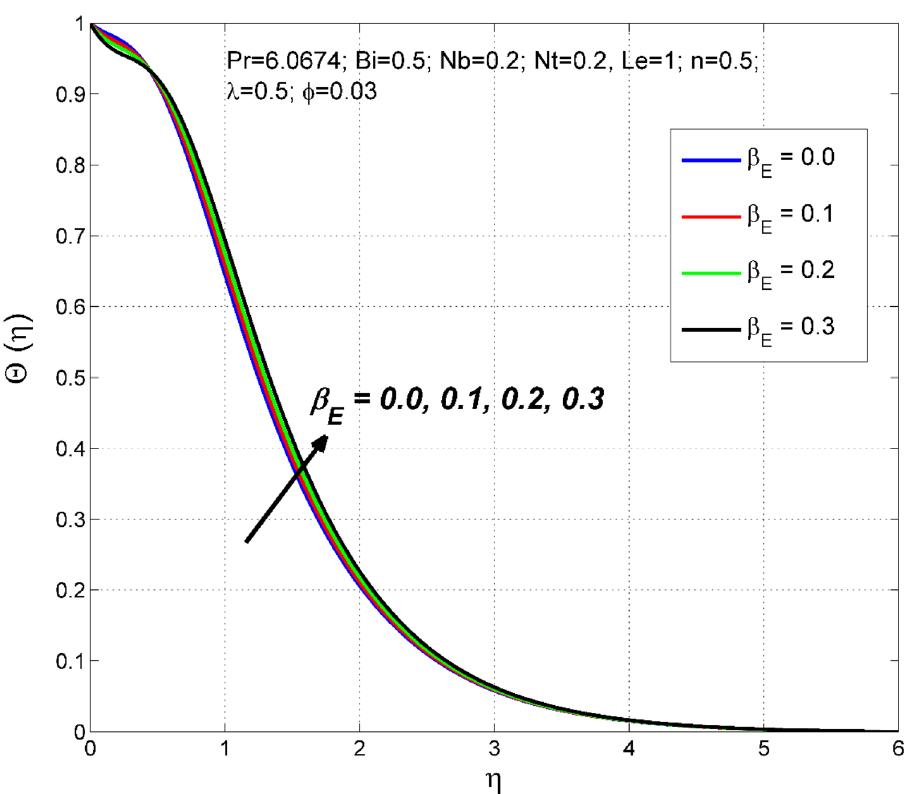
Figure 8. The nanoparticles volume fraction distribution �(η) behavior for the variation of the exponential heat source β E